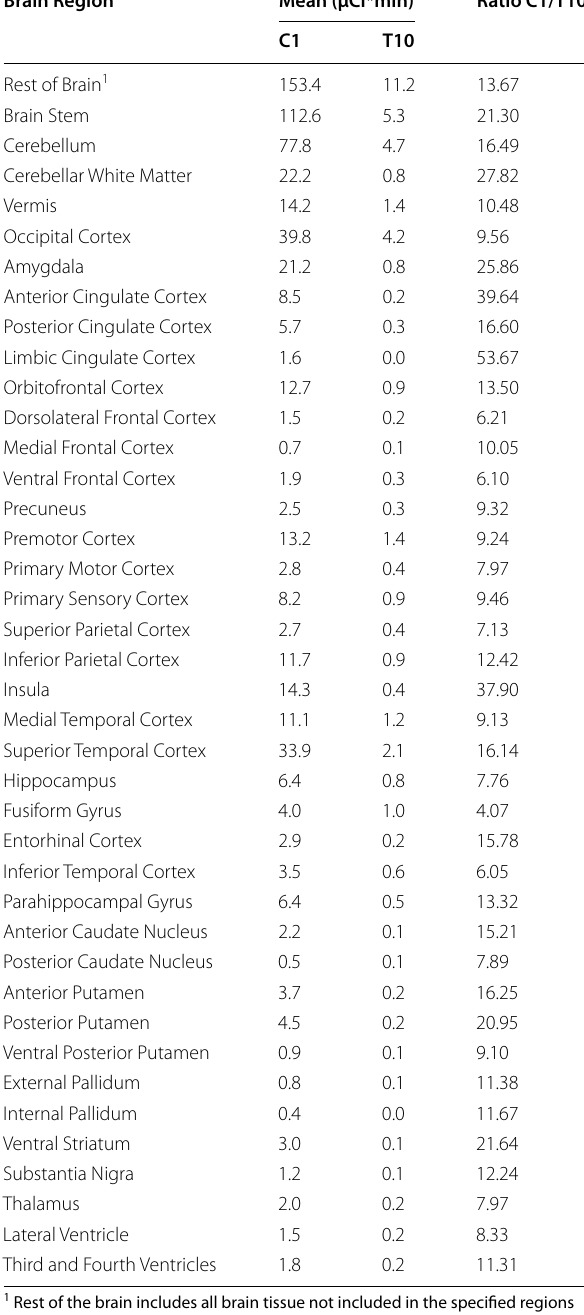
Table 1 Mean tracer concentrations by grouped brain regions and ratio of concentrations by catheter tip level